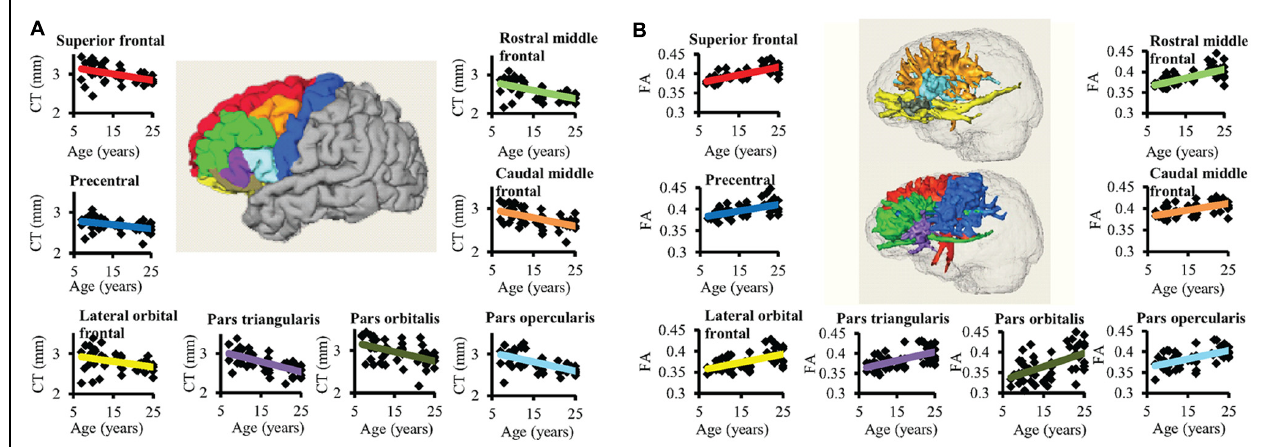
FIGURE 3 | The age-dependent CT decreases and corresponding WM FA increases for eight left frontal regions are shown in (A) and (B), respectively. In the center of (A) , parcellated left frontal gyri were encoded with following colors: superior frontal (red), precentral (blue), lateral orbital frontal (yellow), pars triangularis (purple), pars orbitalis (dark green), pars opercularis (light blue), caudal middle frontal (orange), and rostral middle frontal (green). The colors of the fitted CT decrease trend lines in (A) are consistent to those of parcellated gyri in the center. In (B) , the three-dimensionally reconstructed WM tracts used for FA measurement in the center were traced from corresponding frontal gyrus and encoded with the same colors as those shown in the parcellated left frontal gyri in the center of (A) . The same color scheme used in the fitted trend lines in (A) was used for the fitted trend lines in (B) . TABLE 1 | Pearson correlational coefficient ( r ), correlation significance ( p ) and slopes of fitted linear trend line are shown for age-dependent cortical thickness (CT) (middle column) and corresponding white matter (WM) fractional anisotropy (FA; right column) for all frontal lobe gyri in the left (lh) and right (rh) hemisphere. CT vs. age FA vs. age